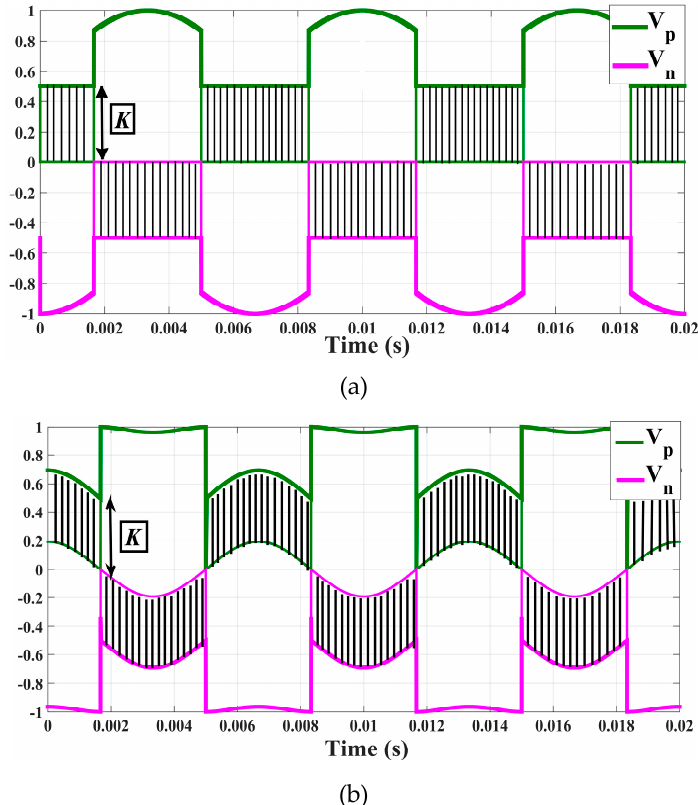
Figure 5. ZSI-DCPWM envelopes: ( a ) Conventional ZSI-DCPWM envelopes, ( b ) Proposed modified DCPWM